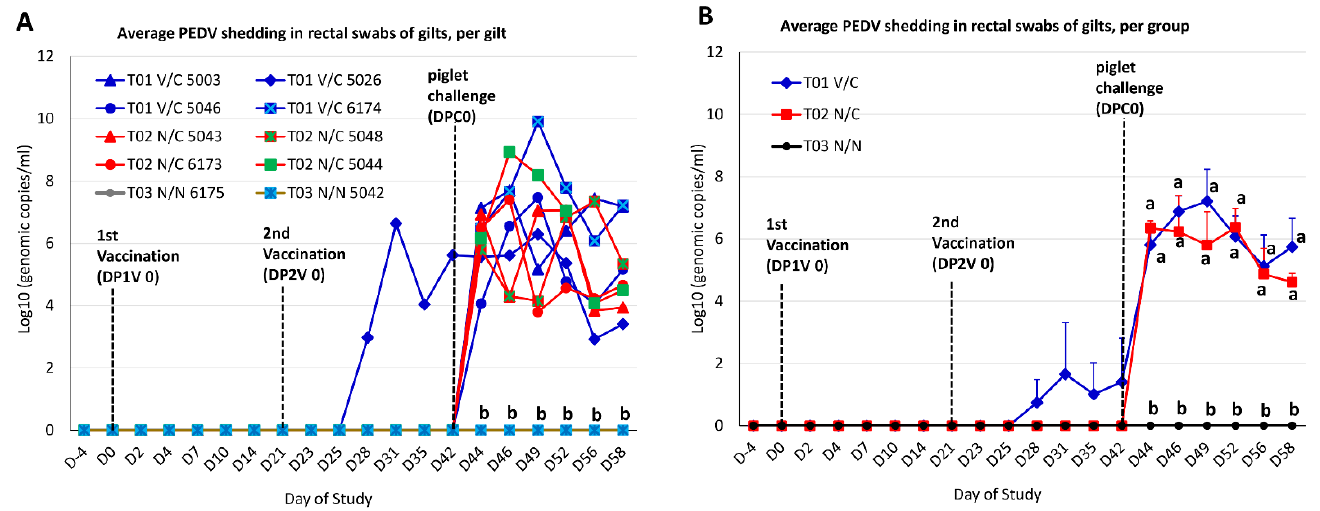
Figure 2. PEDV shedding in rectal swabs of gilts as determined by a quantitative PEDV N gene-based RT-PCR. ( A ) The virus titers in individual gilts at each time point. ( B ) The virus titers at each time point were the mean values of the gilts (both PCR positive and PCR negative gilts) in each group. Different letters indicate significant differences.